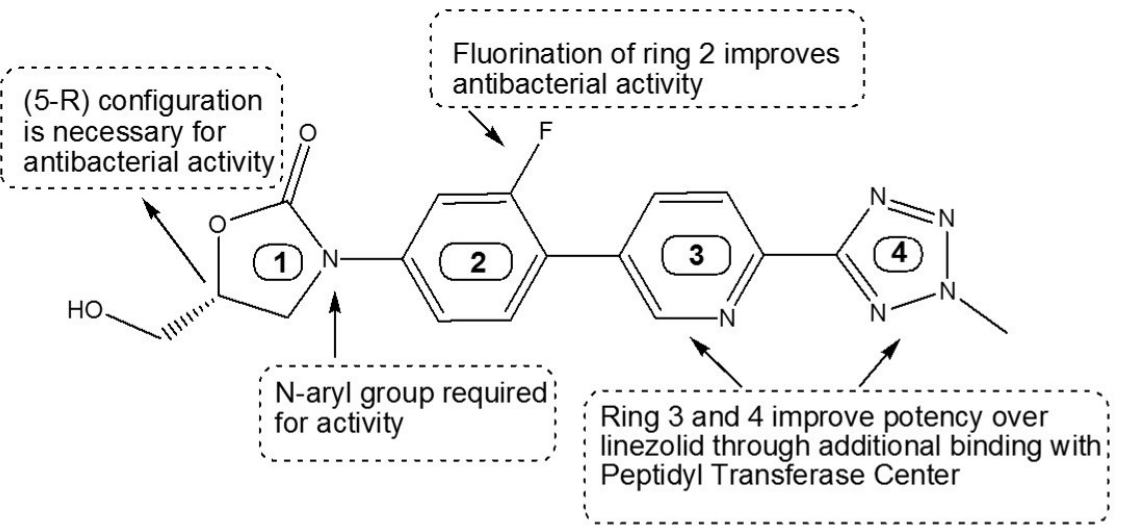
Figure 1. The chemical structure of TDZ, where 1–4 symbolizes the different aromatic rings present in the structure of TDZ. Ring-1 represents the oxazolidinone nucleus; Ring-2 is the meta-fluorine and para-oriented electron withdrawing group; Ring-3 is the pyridine ring and Ring-4 is the tetrazole ring.